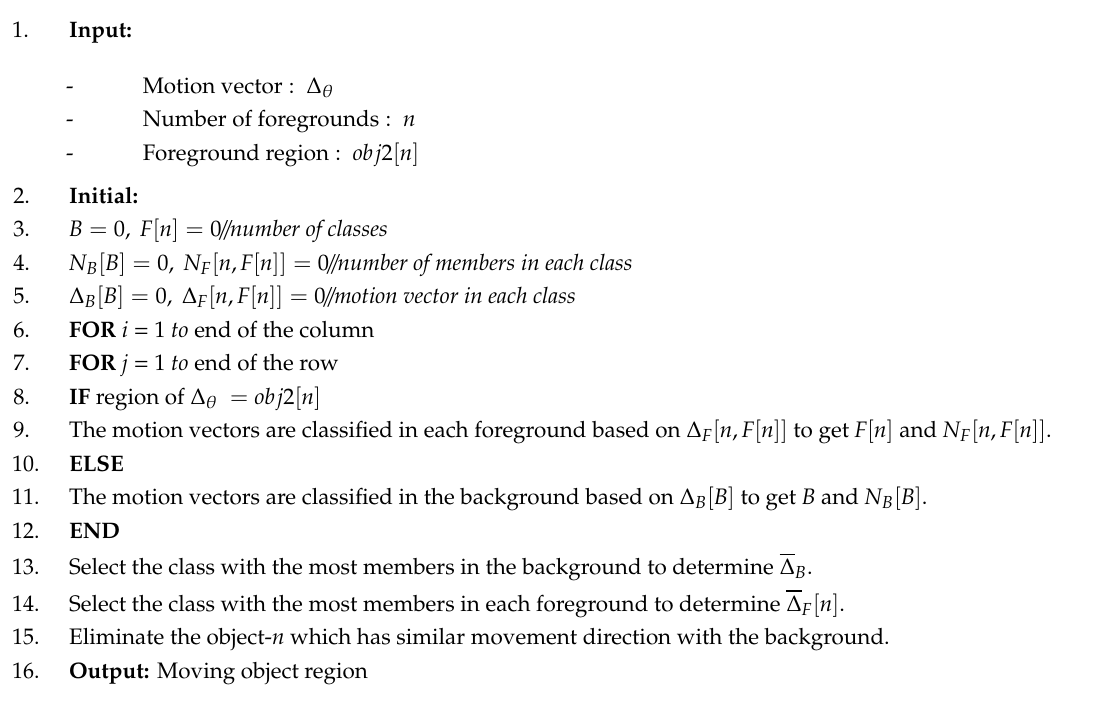
Algorithm 1. The proposed classification for selecting moving objects.